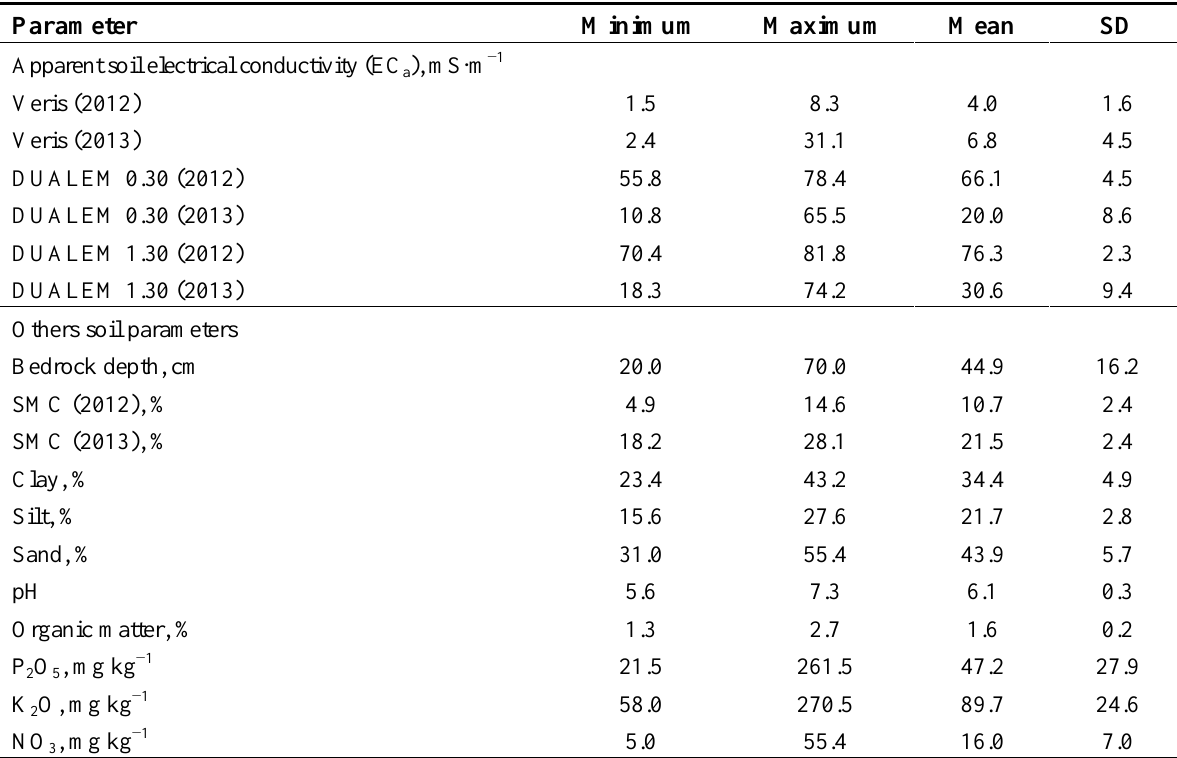
Table 1. Range, mean and standard deviation of apparent soil electrical conductivity and others soil parameters of the experimental field.